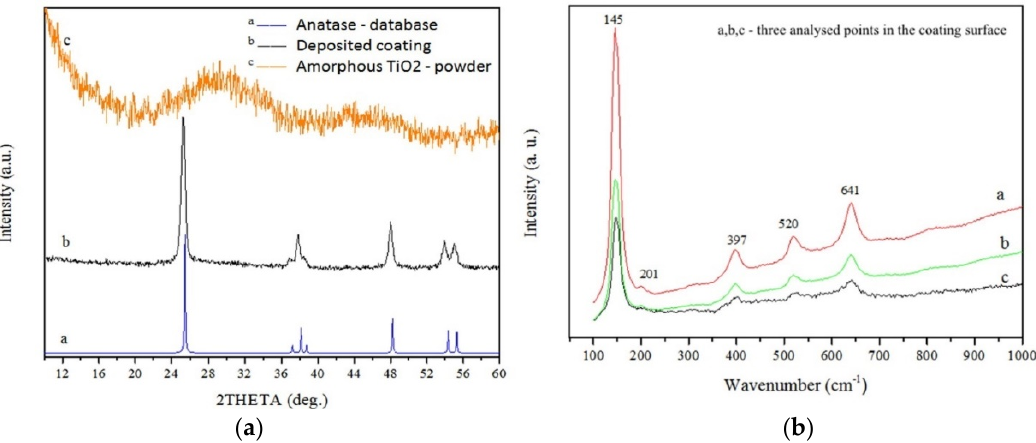
Figure 29. XRD ( a ) and Raman ( b ) spectra obtained for coating deposited of amorphous powder with the use of air preheated to 600 °C. Reprinted with permission from [240]. Copyright 2019 Elsevier.